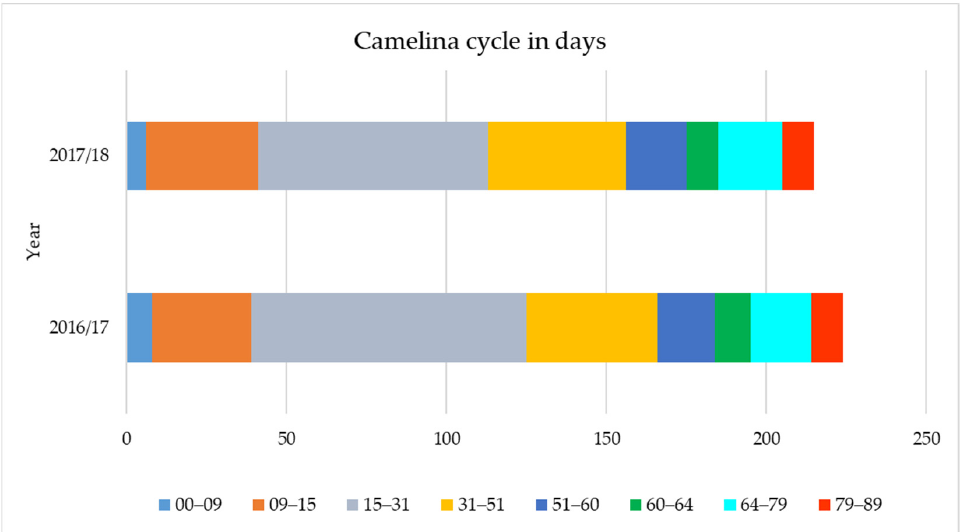
Figure 2. Duration in days of the main phenological growth stages of Camelina sowed in 2016–2017 (Y1) and 2017–2018 (Y2).